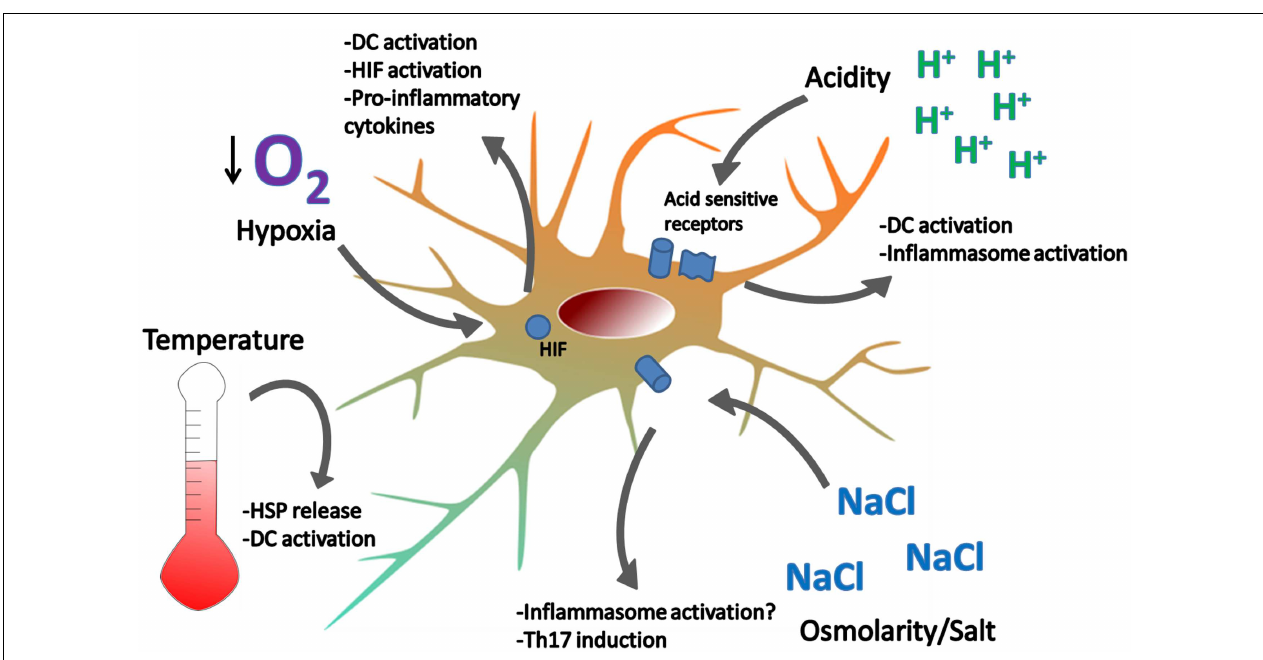
DC activation, NF-kB signaling, and cytokine production. Acidity is sensed by acid-sensing ion channels and acid-sensing G-proteins, leading to DC activation. Hypotonicity activates the inflammasome in macrophages and high salt concentrations promoteTh17 responses. How DCs respond to changes in osmolarity remains